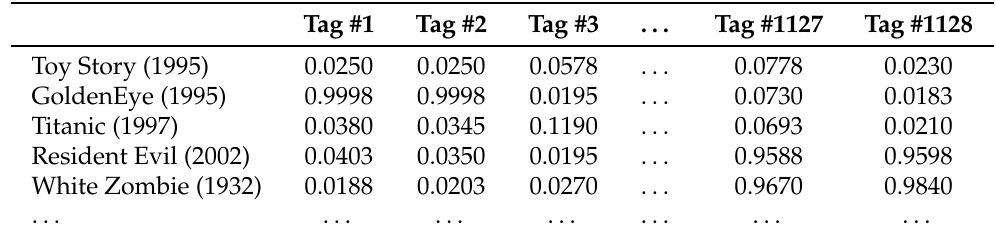
Table 2. Reorganizing original Tag Genome data into a tabular form. Each movie is presented as a row and its genome scores are stored in the columns.